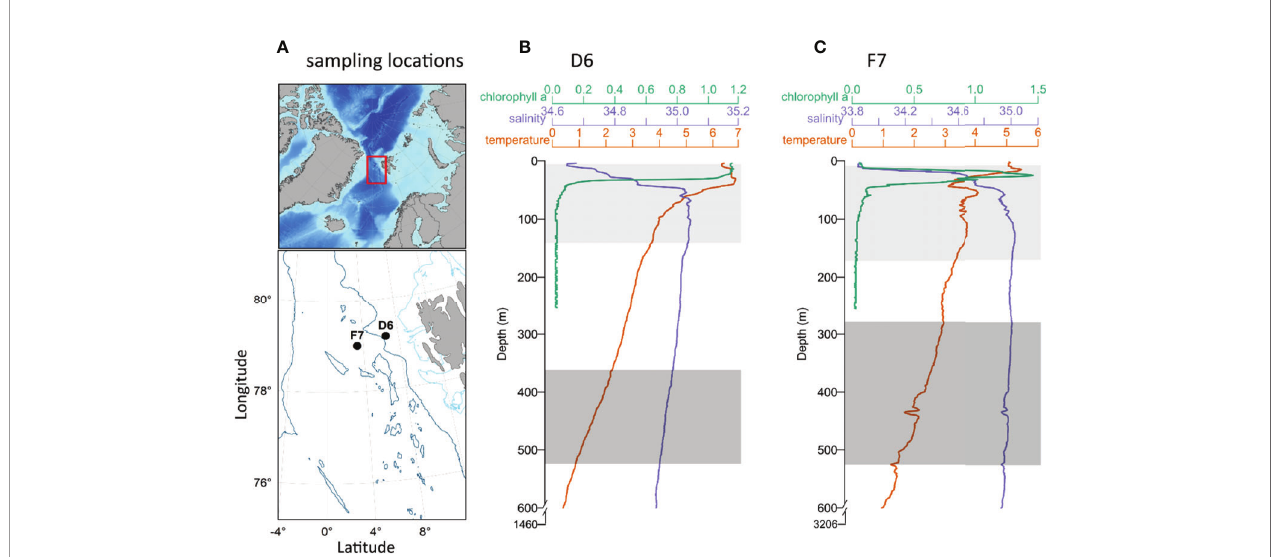
FIGURE 1 | (A) Bathymetric map of the North Atlantic and Arctic Ocean. The area sampled within the Fram Strait (indicated by the red rectangle), shows the locations of slope station D6 and basin station F7 (black circles) west of Svalbard. Light and dark blue contours represent 200 m and 2000 m isobaths respectively. (B, C) Vertical pro fi les of temperature, salinity and chlorophyll A between the surface and 600 m (temperature and salinity) and 270 m (chlorophyll a ), at D6 (B) and F7 (C) also showing total water depth. Light (epipelagic) and dark grey rectangles (mesopelagic) represent the integrated upper and lower depths respectively from which copepods were collected. Physical environment data were provided by Changing Arctic Ocean/Robyn Owen (British Oceanographic Data